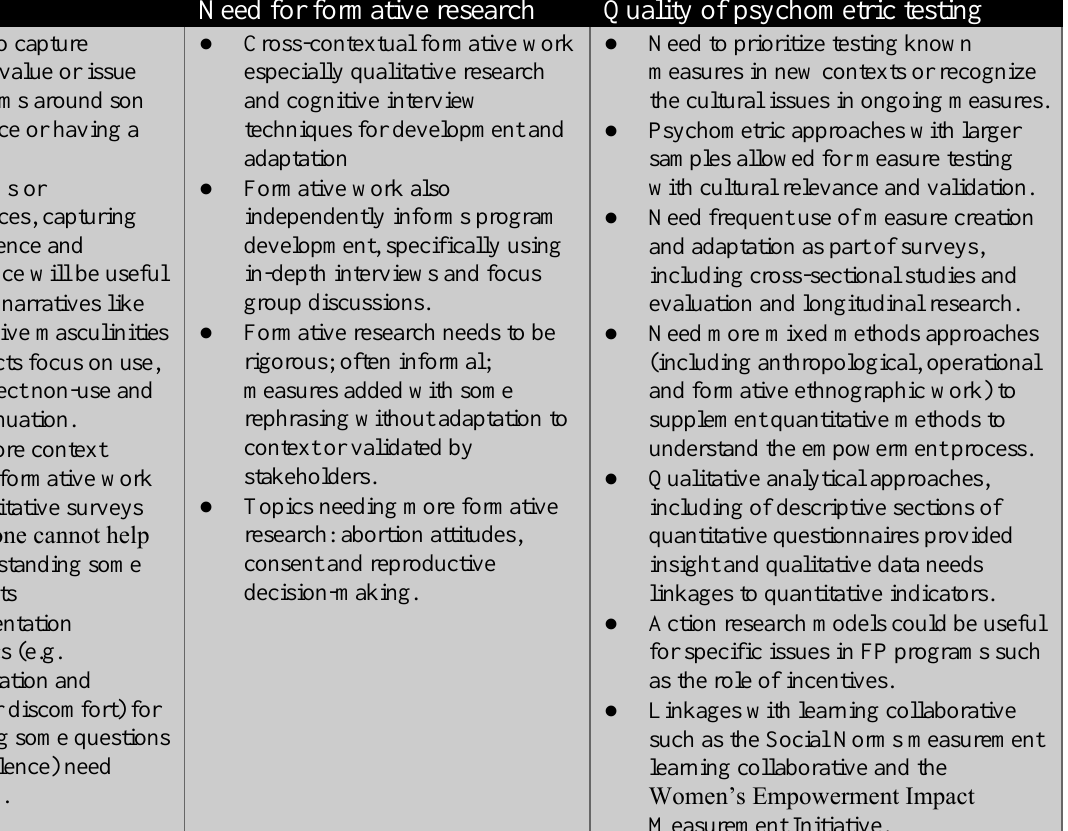
Table 1: Experiences and Insights on Gender Equity (GE) Measures in Family Planning from Experts (January 2020) Conceptualization